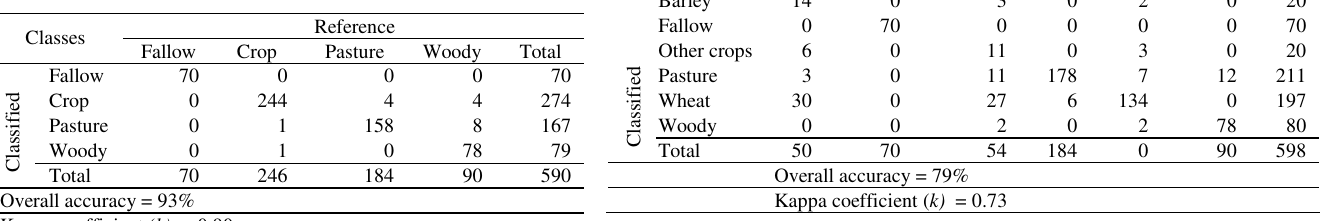
Figure 5. Comparison of Support Vector Machines and Maximum Likelihood Classified images Table 3. Accuracy assessment of winter 2011 classification (major classes only)